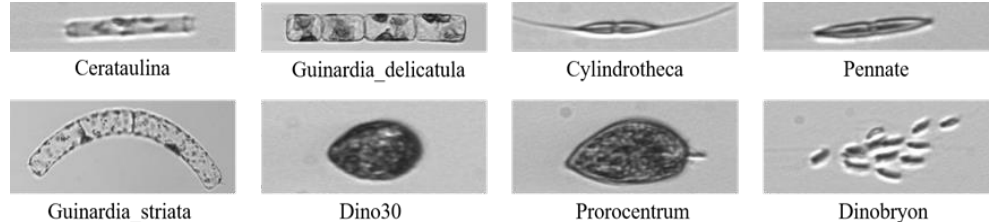
Figure 1. Illustration of the taxa data in this work.